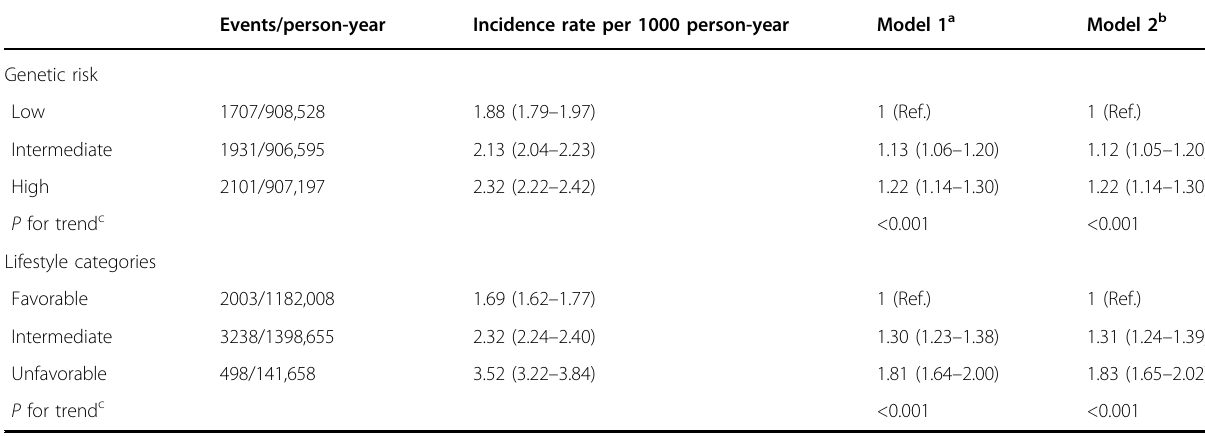
Table 2 Risk of incident depression according to genetic risk and lifestyle